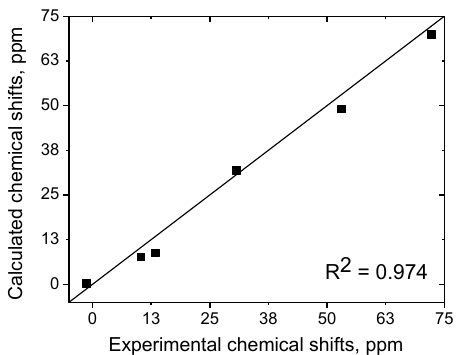
Figure 5. Correlation plot of paramagnetic chemical shifts in the 1 H NMR spectrum collected at the room temperature from the solution of [Fe( L ) 2 ](BF 4 ) 2 in acetonitrile-d 3 and those calculated for its high-spin (HS) species with TPSSh-optimized geometry; ∆ χ ax = 4.51 × 10 − 32 m 3 .